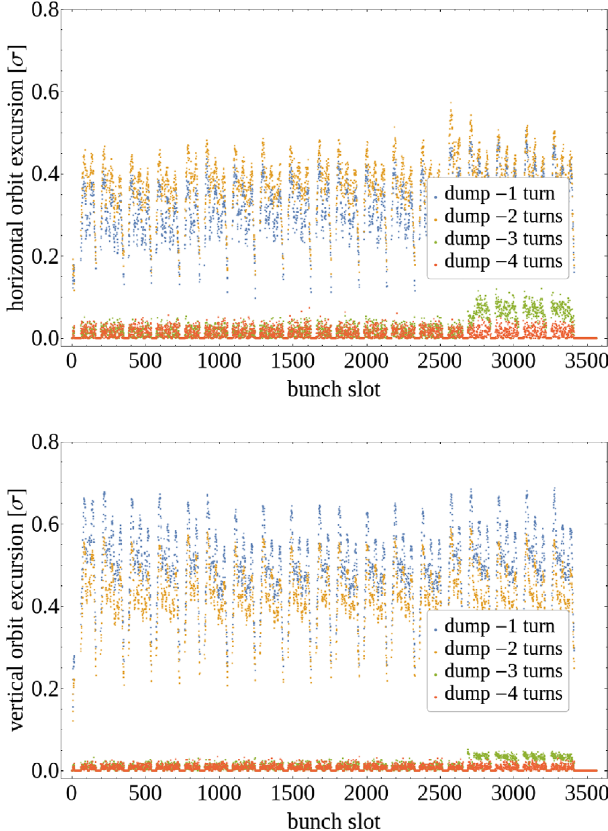
FIG. 17. Measured horizontal (top) and vertical (bottom) orbit excursion of Beam 2 during the last four turns before beam dump of fill 7217. The effect of the loss of the BBK is clearly seen, with a vertical offset reaching 0 . 6 σ and a horizontal offset reaching 0 . 5 σ .